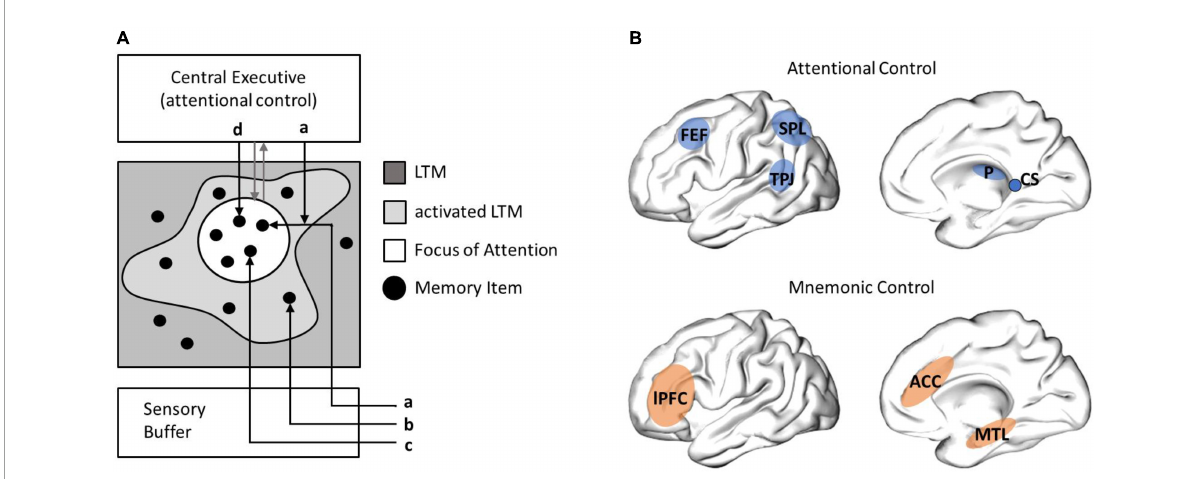
FIGURE1 Cowan’s embedded-process-model and neuroanatomical structures of attentional and mnemonic control. (A) Cowan (1988) suggests that attention and memory processes act on activated representations in long-term memory (LTM, so called memory items). The focus of attention is controlled by the central executive (gray arrows) and lies on a subset of activated items: sensory information may be (a) selectively attended, (b) guide automated behavior, if they are habituated, (c) enter the focus of attention immediately, if unexpected and thus dishabituated, or (d) activated by central executive processes. Cowan emphasizes that information processing serves behavioral navigation, namely controlled actions, guided by the central executive, or automated actions, based on highly habituated processes (not illustrated in this graph). (B) A central role for selective attention processes is ascribed to the frontal eye field (FEF) and the superior colliculi (CS), in eye-movement control, as well as the pulvinar (P), the superior parietal lobe (SPL) and the temporal parietal junction (TPJ), in cortical attentional control (adapted from Posner and Rothbart, 2007). A central role for mnemonic control processes has been ascribed to the lateral prefrontal cortex (lPFC), the anterior cingulate cortex (ACC), and the medial temporal lobe